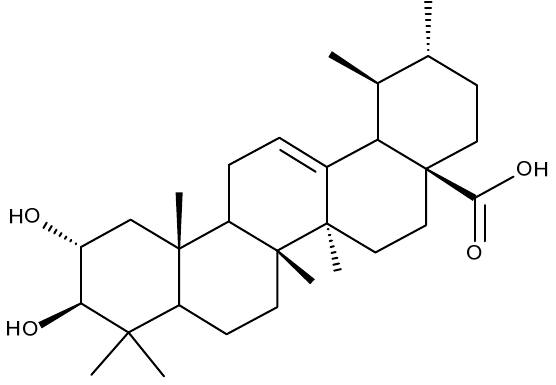
Figure 9. Structure of corosolic